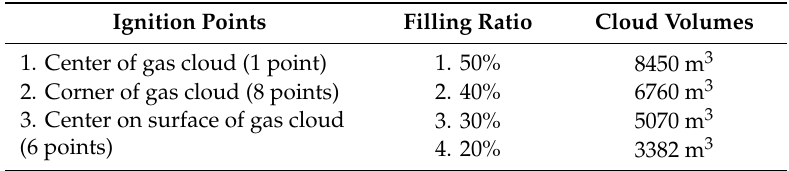
Table 4. Blowout and explosion scenarios above the drill floor.